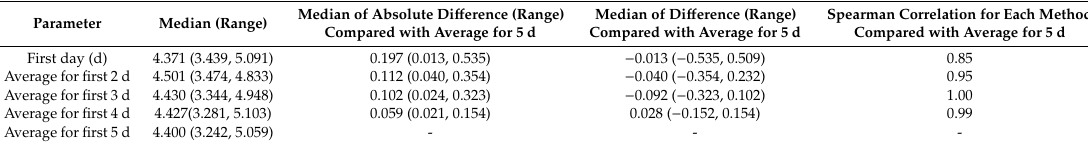
Table 5. Peak acceleration of leg movement.